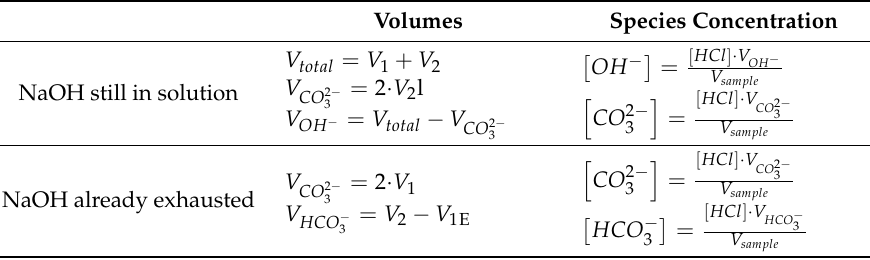
Table 2. Volumes and species concentrations obtained by